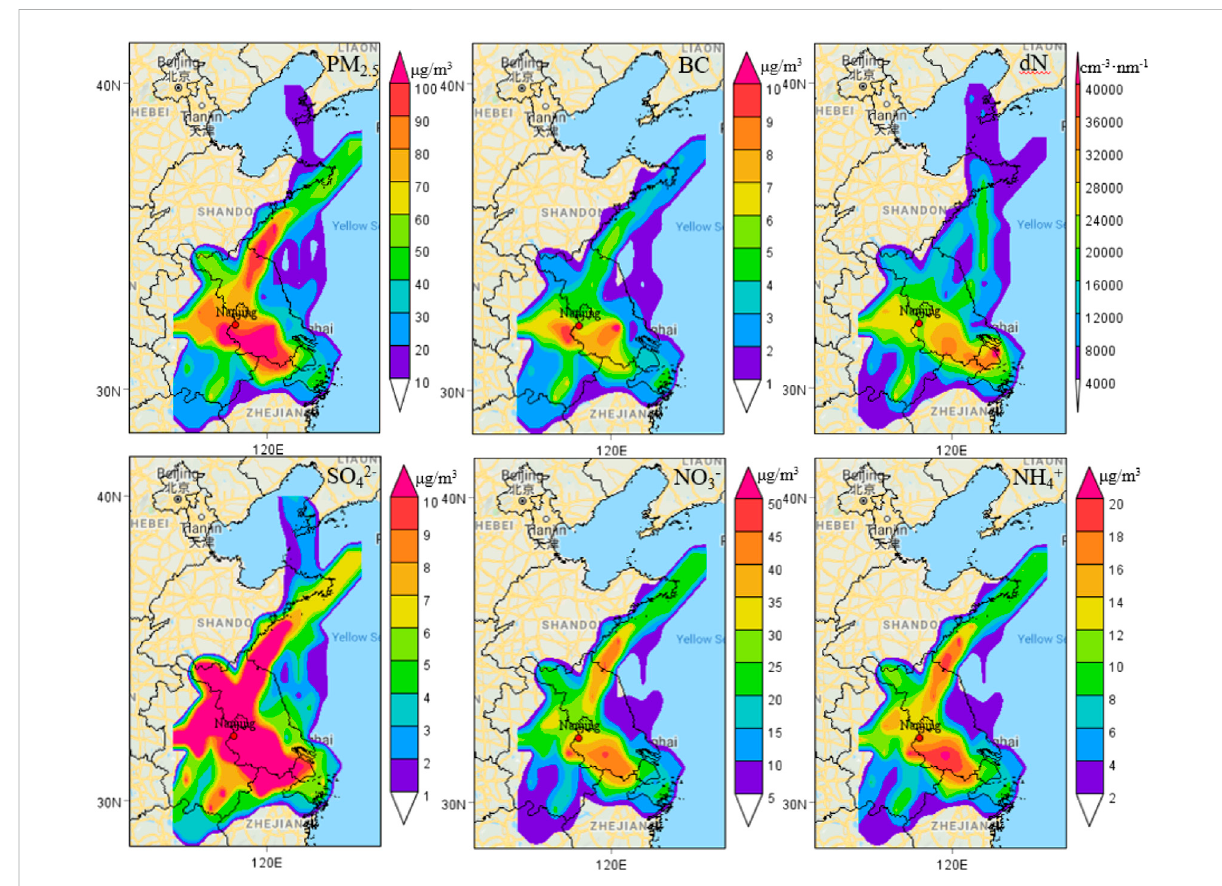
FIGURE 6 The CWT analysis of major pollutants with a backward trajectory during the